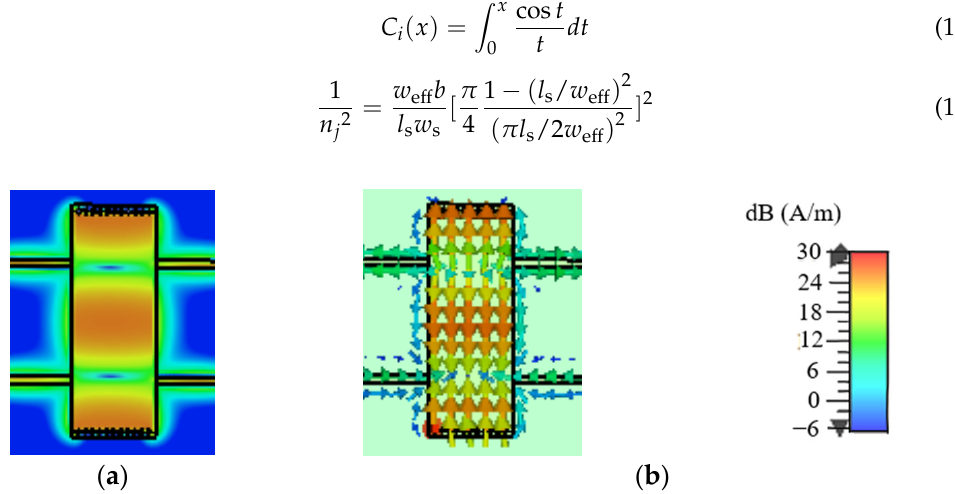
Figure 2. The surface current distributions on the SIW without slots for DM operating at f 0 . ( a ) The uniform amplitude distributions. ( b ) The vector distributions.